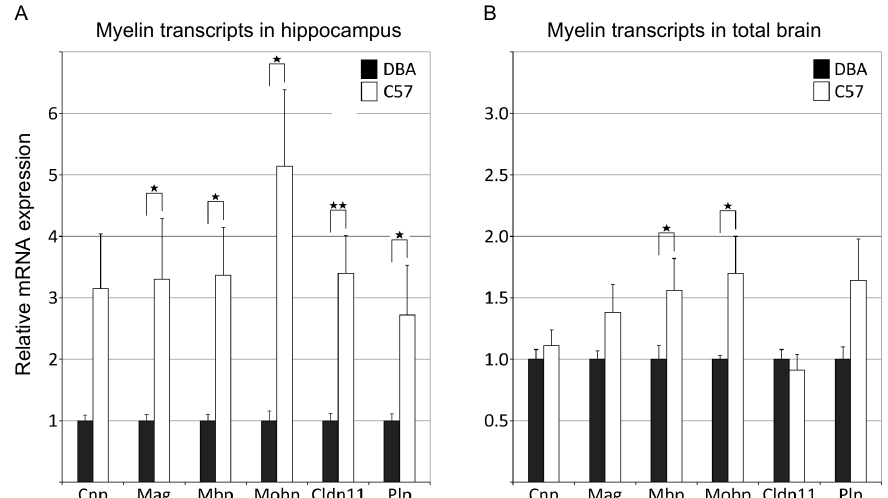
Figure 3. qPCR analysis confirms myelin gene expression differences between the parental C57 and DBA strains. ( A ) qPCR was performed on myelin gene transcripts in hippocampi from C57 and DBA mice. For nearly all myelin genes investigated, gene expression differences were significant, with C57 mice showing higher levels of expression. ( B ) qPCR analysis on myelin gene transcript in total brain tissue (minus hippocampus). DBA, n = 5; C57, n = 6. t -test (1-tailed) ** p < 0.01; * p < 0.05.